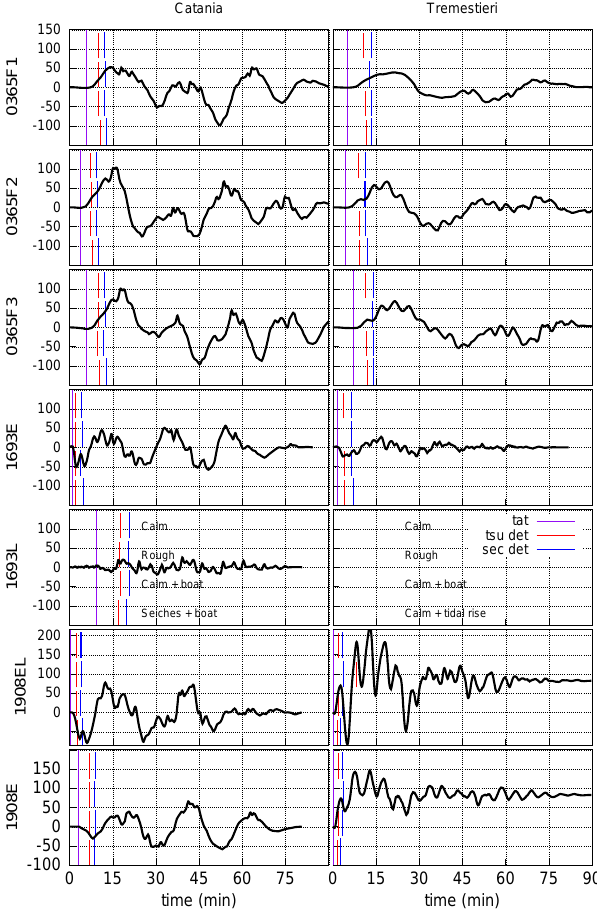
Fig. 10. Synthetic tsunami signals for Catania and Tremestieri com- puted through numerical modelling. The estimated tsunami arrival time (TAT) is indicated with a vertical line (violet). TEDA de- tections for all the four windows are indicated (tsunami-detection method, red, and secure-detection method, blue) for the best con- figuration and for the different sea-state conditions. In general, the TEDA secure method provides later